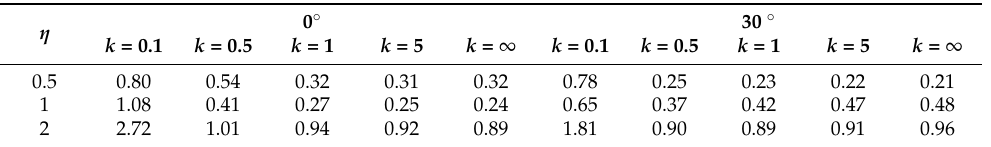
Table 7. Mean value of variation coefficient of vertical displacement amplitude (with permeability